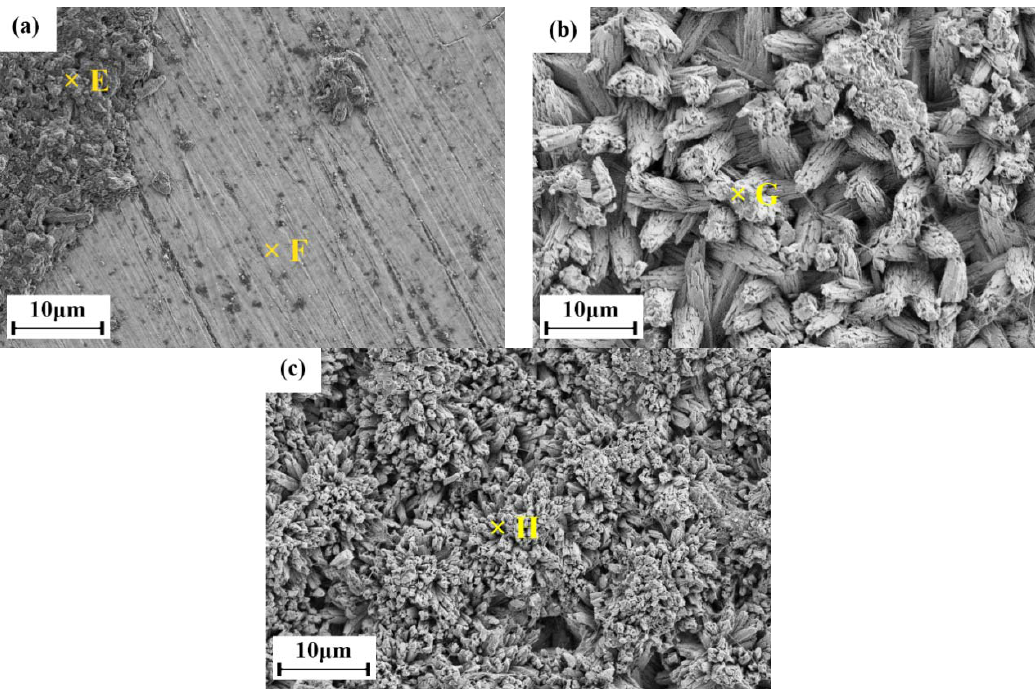
Figure 8. Surface morphology of 304 SS with polarization at − 0.65 V for 20 h ( a ), 70 h ( b ) and 168 h ( c ).